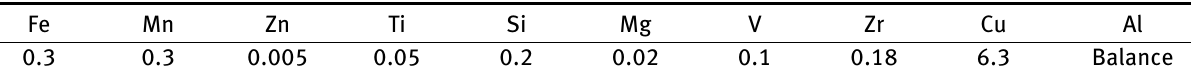
Table 1: The chemical composition of Al2219 alloy in percentage by weight Fe Mn Zn Ti Si Mg V Zr Cu Al 0.3 0.3 0.005 0.05 0.2 0.02 0.1 0.18 6.3